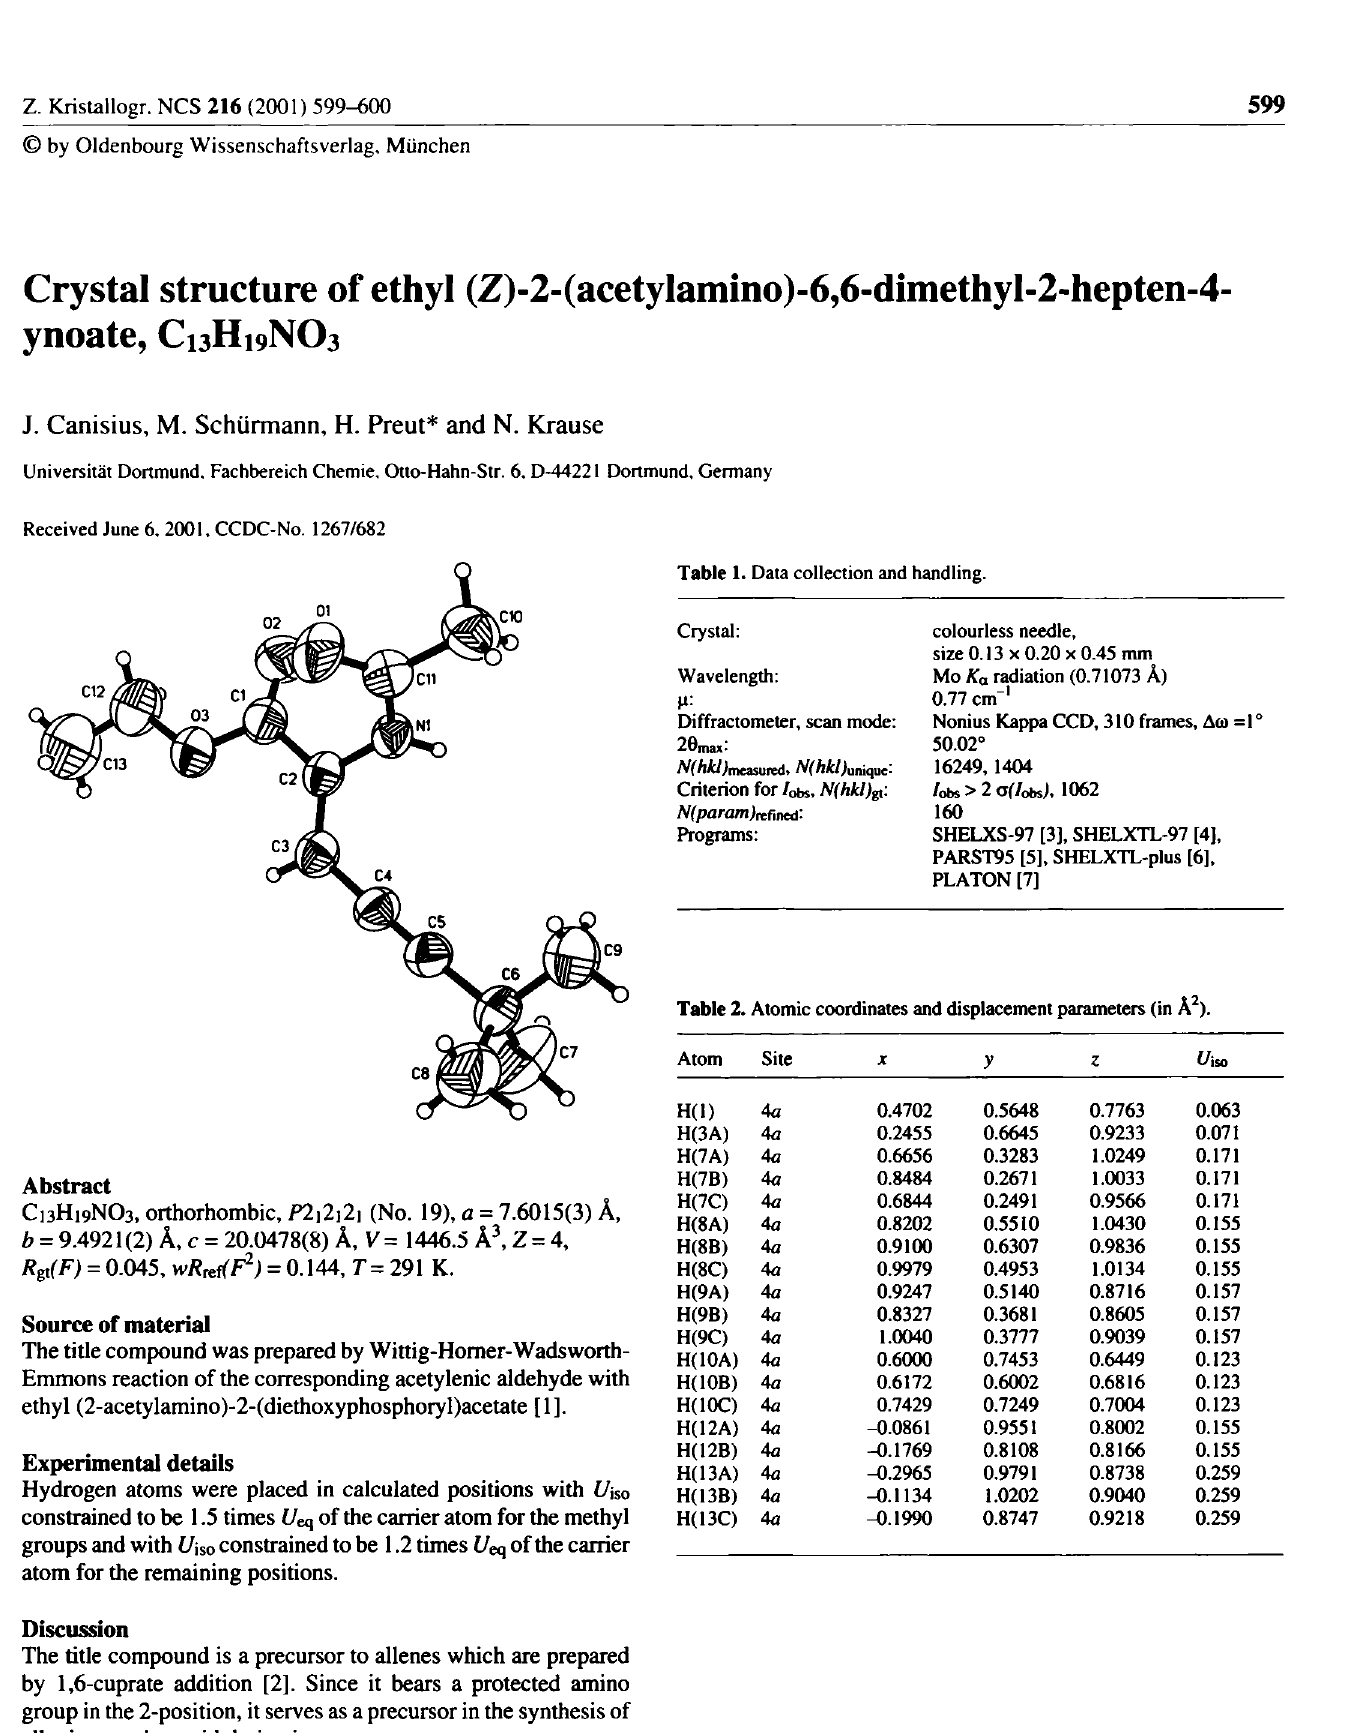
Table 2. Atomic coordinates and displacement parameters (in A 2